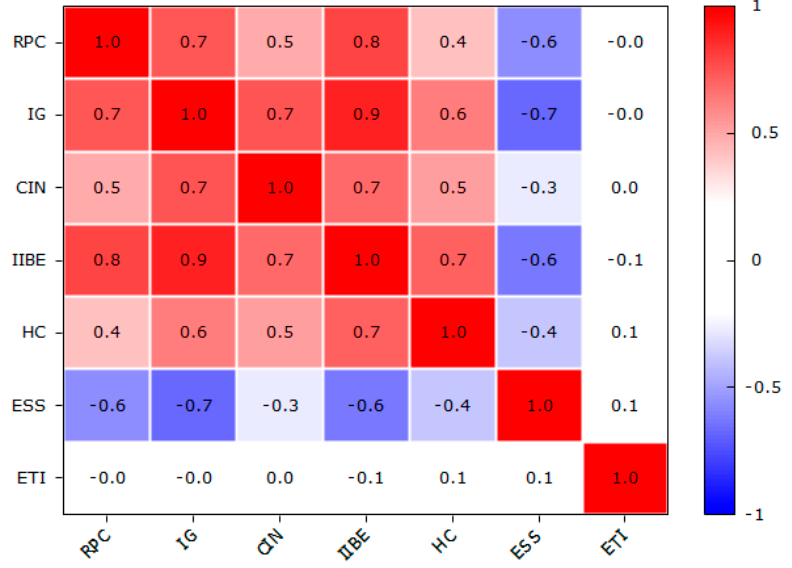
Figure 3. Correlation between the ETI and its subindices.